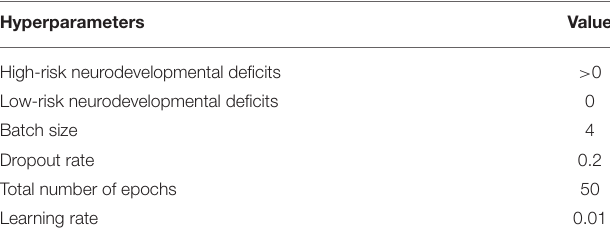
TABLE 2 | Hyperparameters for the unsupervised and supervised